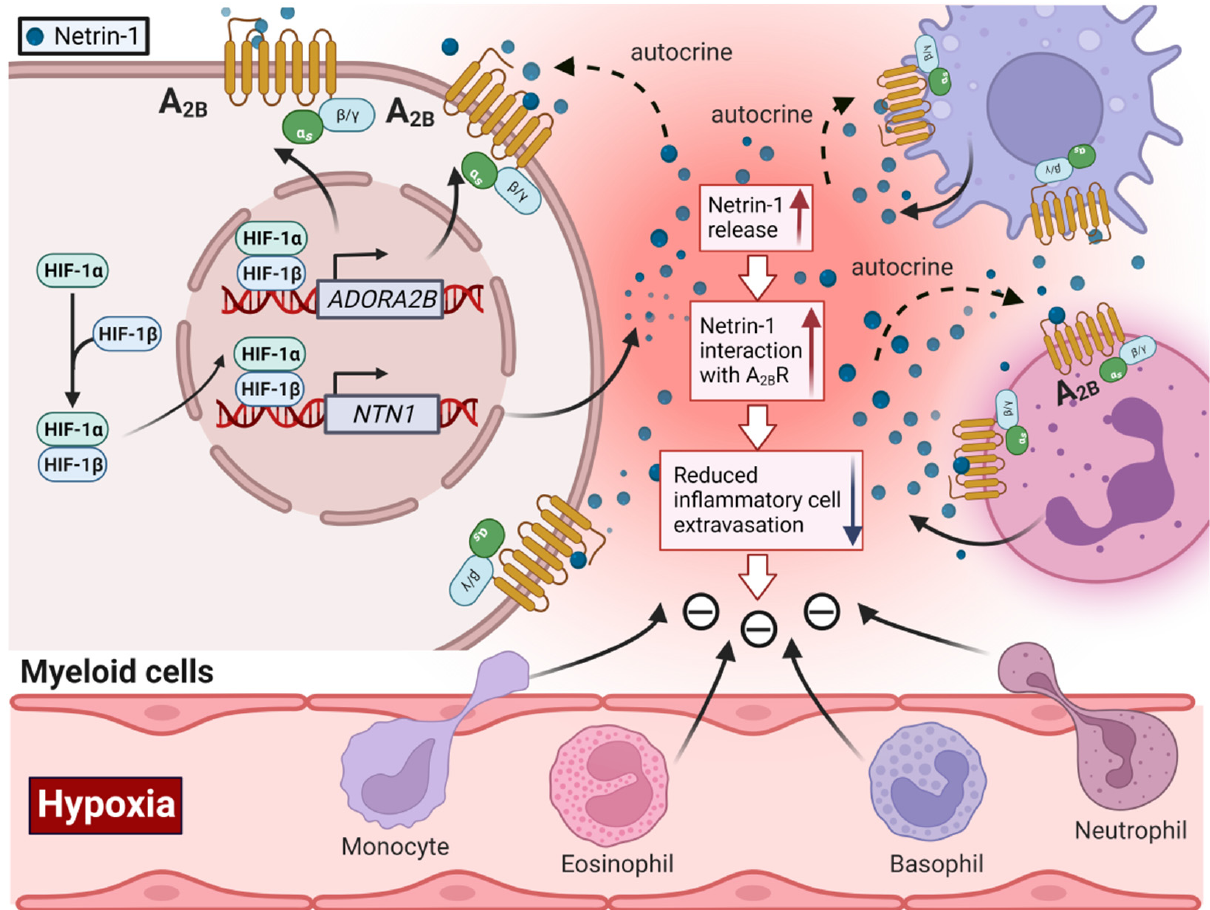
Figure 3. HIF coordinates alternative adenosine receptor signaling via increasing netrin-1 expression and signaling through Adora2b. During myocardial reperfusion injury, different types of inflammatory cells, such as neutrophils, monocytes, etc. infiltrate into the myocardial tissue. This further exacerbates tissue hypoxia and tissue damage. During reperfusion, the transcript and protein levels of Netrin-1 are robustly increased in patients with myocardial ischemia and in mice with myocardial IR injury. The increased expression of netrin-1 is mediated by HIF1A activity, which can bind to an HRE within the Netrin-1 promoter. The increased release of netrin-1 enhances Adora2b signaling by interacting with myeloid Adora2b in an autocrine manner, dampens the accumulation of inflammatory cells, and ultimately mediates cardioprotection against IR injury. The red arrowhead denotes increase, and the dark blue arrowhead denotes decrease. A2 B : Adenosine A2b Recep- tor. NTN1 : Netrin-1.